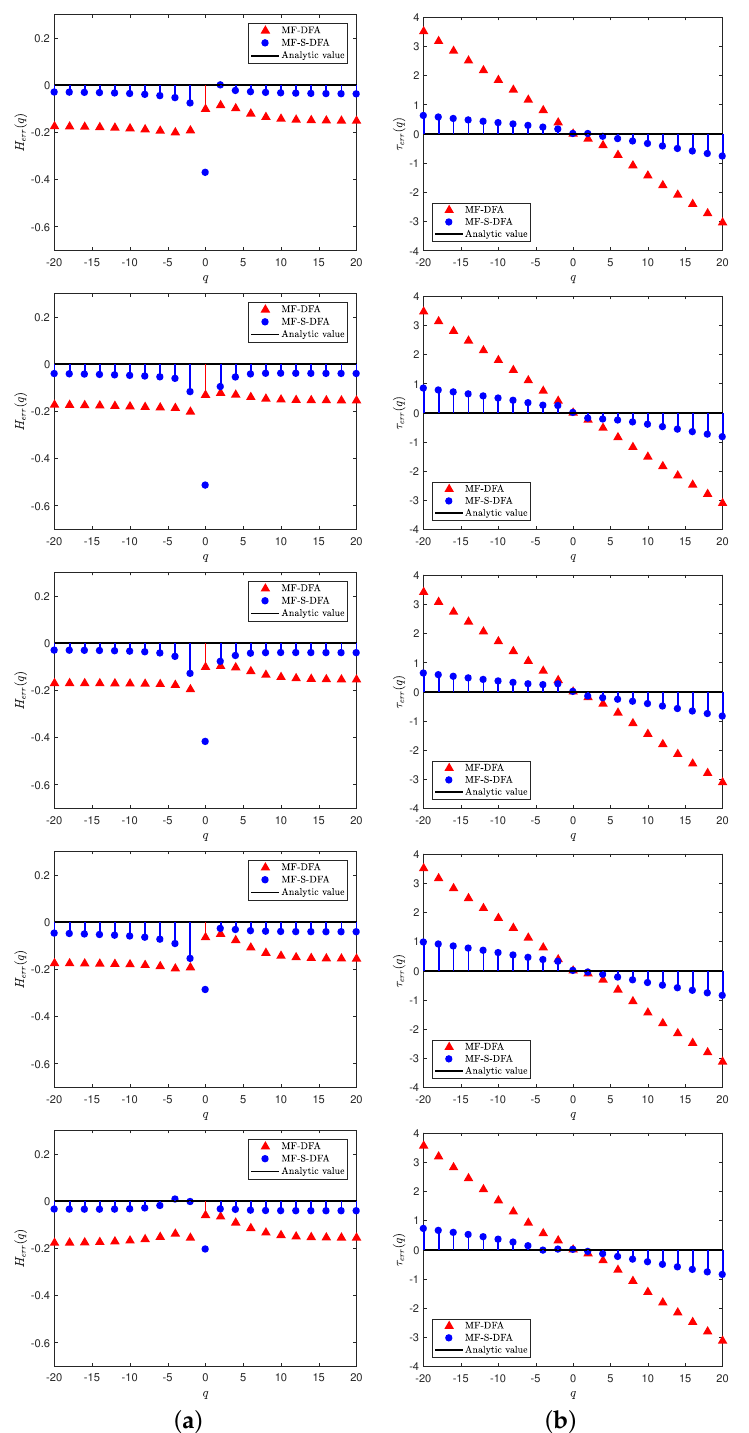
Figure 6. Comparison of MF-DFA and MF-S-DFA for different parameters of n max : ( a ) H err ( q ) and ( b ) τ err ( q ) . From top to bottom, n max = 8, 9, 10, 11, 12 and 13, respectively. A color version of the figure is available in the web version of the